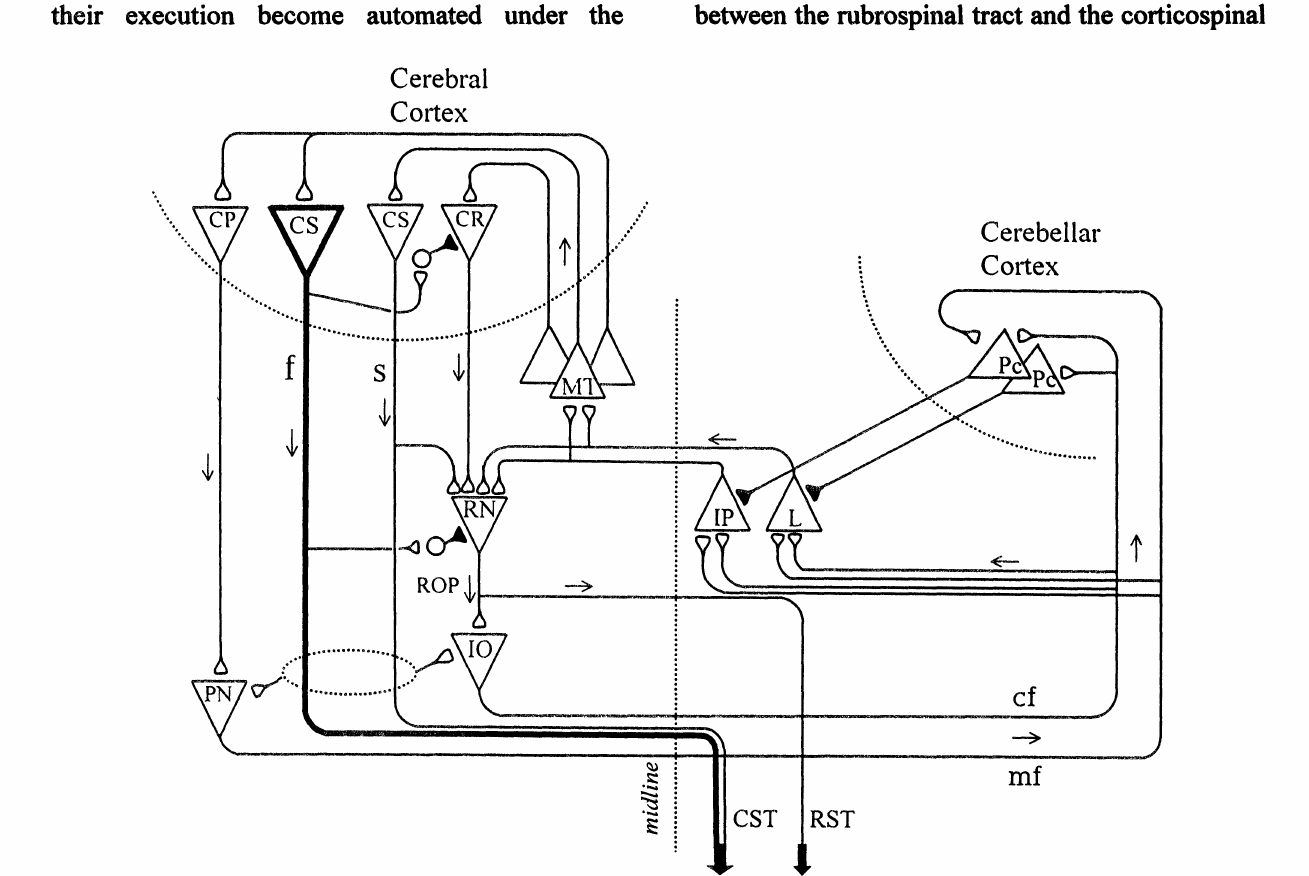
Fig. 6: Diagram ofneuronal circuitry of interrelation and substitution of eortieispinal and eortieo-rubrospinal systems. Corticispinal (CST) projections arise from fast-conducting (CSt) and slow-conducting (CSs) pyramidal tract cells. Cortieo-rubral projections arise from eorieorubral (CR) cells in. the cerebral cortex. CSs and CR are connected monosynaptieally with rubrospinal tract (RST) cells ofthe red nucleus (RAN). Neurons of RN receive cerebellar inputs via contralateral n.interpositus (IP) and n. lateralis (L), which are projected also to the cerebral cortex through the motor thalamus (MT). Rubro-olivary projection (ROP) are terminated on the inferior olive (IO), which sent olivo-cerebellar fibres (climbing fibres, el) to Purkinje cells (Pc) and neurons of eerebellar nuclei (IP,L). CSf exert inhibitory influences via intemeurons on CR and RST cells. Cortieopontine projections (CP) to the pontine nuclei (PN) provides polysynaptie connections from the cerebral cortex to the cerebellum, since efferent neurons of the PN projects onto the eerebellar cortex and its nuclei as mossy fibres (mf). CSf are indicated by thick line. Excitatory and inhibitory projections are indicated by open and filled knobs. Arrows show direction of information